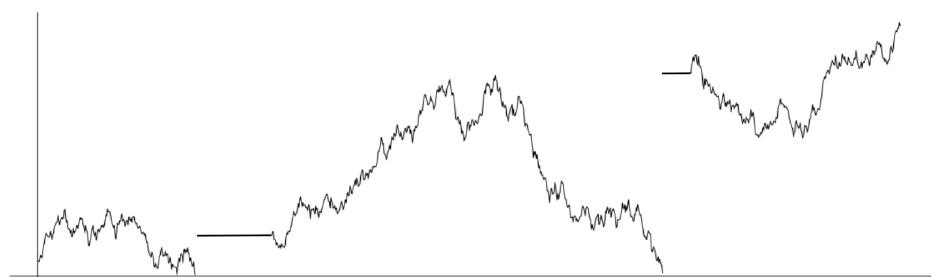
+ R γ ◦ ¯ V − 1 Figure 9. The path of X + ◦ ¯ V − 1 . The process exhibits a jump and stop behavior near the t t boundary. Indeed, the process never hits the zero point boundary; it jumps near the boundary according to R γ , and then it stops for a random amount of time according to ¯ V − 1